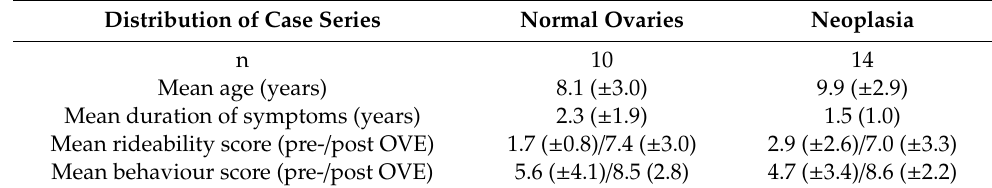
Table 2. Age, duration of symptoms, rideability and behaviour scores in mares with and without neoplasia. Four cases were excluded due to no histopathologic examination.